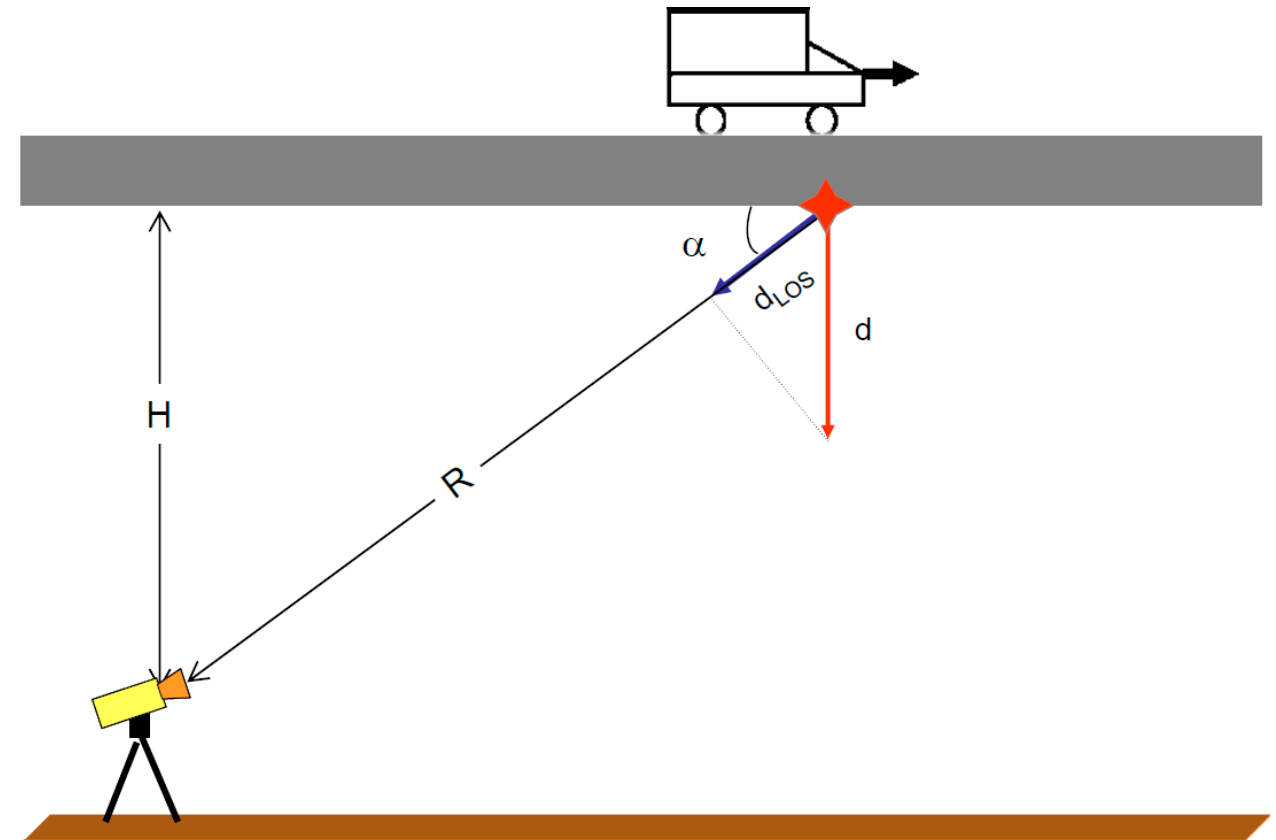
Figure 1. Line of sight movement (d LOS ) and expected (calculated) vertical movement (d), R—radar distance from the measured point, and H—radar distance from the measured point in vertical direction.